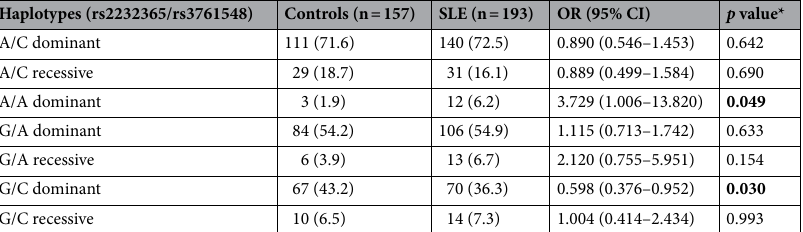
Table 3. Distribution of FOXP3 -924 G > A (rs2232365) and -3279 C > A (rs3761548) haplotype models among patients with systemic lupus erythematosus (SLE) and controls. Bold values represent statistically significant values: OR (odds ratio) and CI (confidence interval) 95%. *Adjusted by age and ethnicity. Haplotype models: A/C dominant (A/C carriers versus A/A, G/C, and G/A carriers), A/C recessive (ACAC versus A/A, G/C, and G/A carriers), A/A dominant (A/A carriers versus A/C, G/A, and G/C carriers), G/A dominant (G/A carriers versus A/C, A/A, and G/C carriers), G/A recessive (GAGA versus A/C, A/A, and G/C carriers), G/C dominant (G/C carriers versus A/C, A/A, and G/A carriers), and G/C recessive (GCGC carriers versus A/C, A/A, and G/A